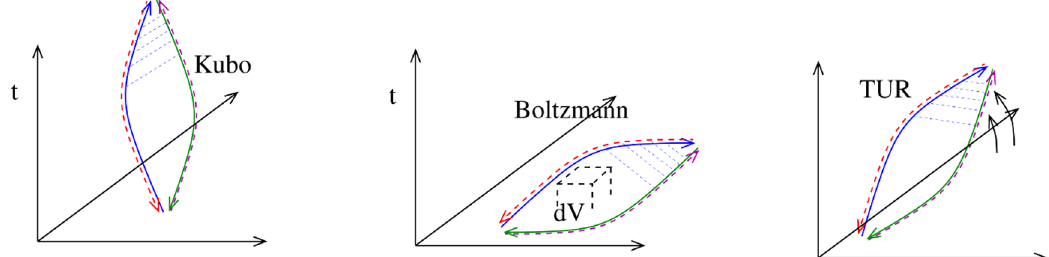
Figure 2 . Left panel: a purely time-oriented contour, reproducing the Kubo formula. Center panel: a space-like contour, expected to reproduce Boltzmann entropy contour. Right panel: the same contour slightly tilted in time, expected to produce hydrodynamic uncertainity relations and anomalous energy dissipation eq.